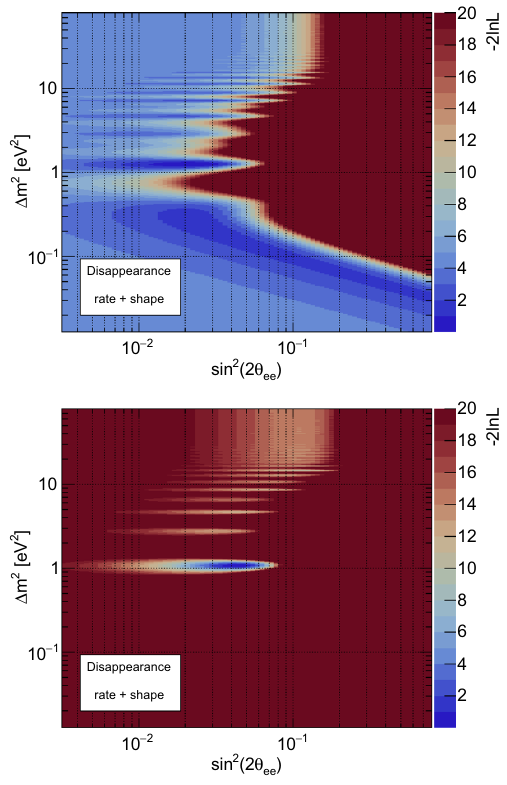
Fig. 7 Negative logarithm of the likelihood function for two sets of pseudo-data generated for the toy disappearance experiment, assuming the no-signal hypothesis (above) and the existence of a sterile neutrino with sin 2 ( 2 θ) =0.04 and Δ m 2 =1eV 2 (bottom). Both maps are normal- ized to the absolute minimum in the sin 2 ( 2 θ) - Δ m 2 parameter space